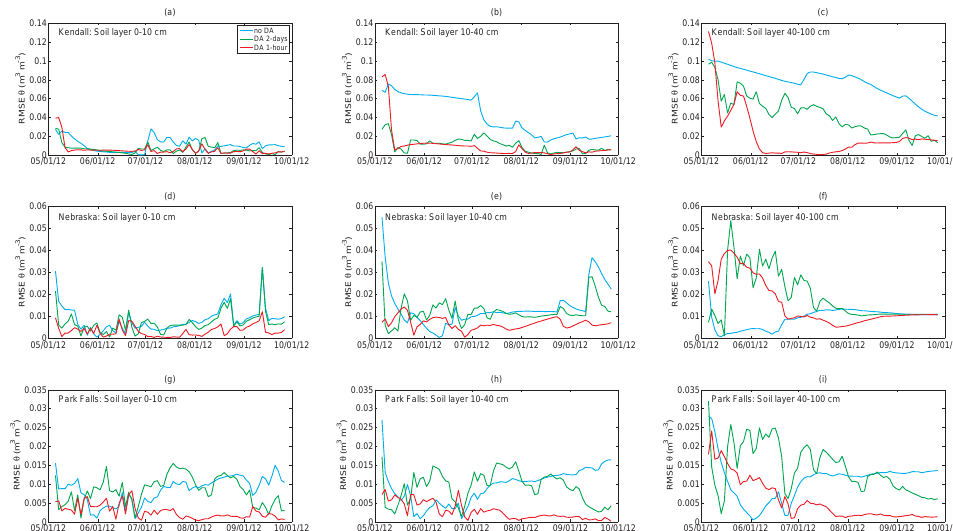
Figure 9. Comparison of Noah performance in representing soil moisture dynamics for the first three soil layers with respect to the true soil moisture state. The metric used is the Root-Mean-Squared Error (RMSE) calculated over individual 2-day periods continuously. Results are shown for Noah without (no DA) and with data assimilation, characterized by low- and high-frequency retrievals (respectively, DA 2-day and DA 1-hour). The ensemble mean of the prior distribution is used for all ensemble